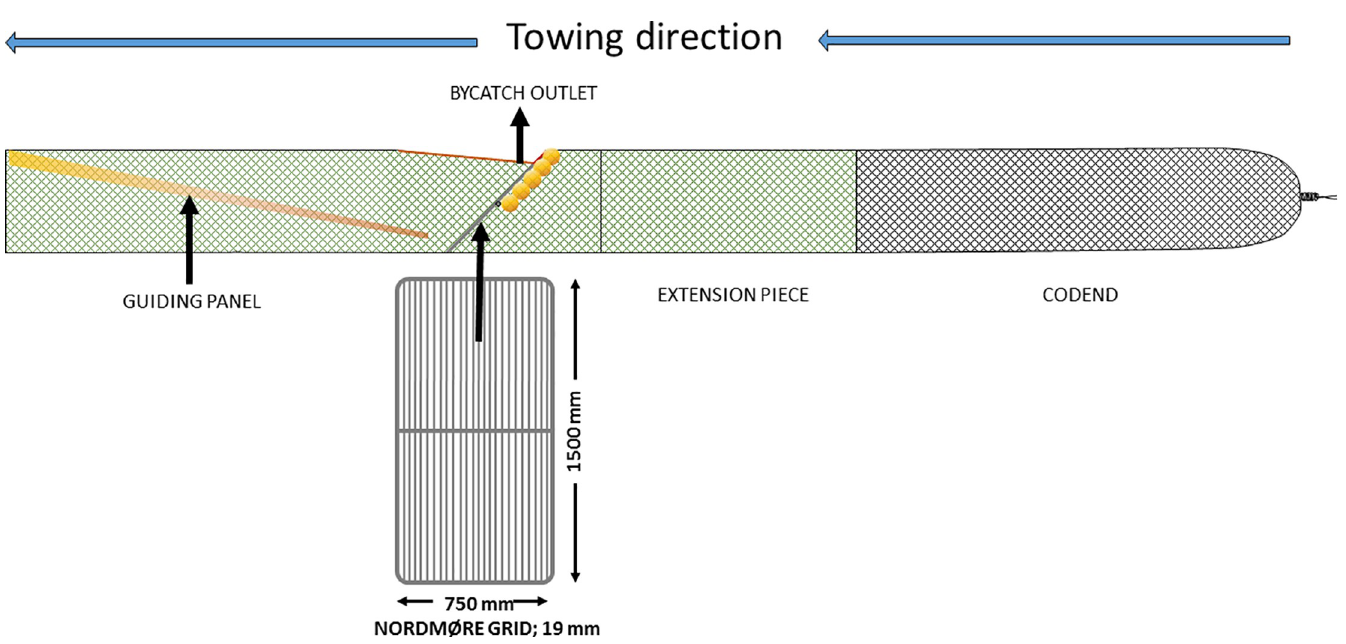
Fig 1. Illustration of a typical Nordm ø re grid and codend design (side view).